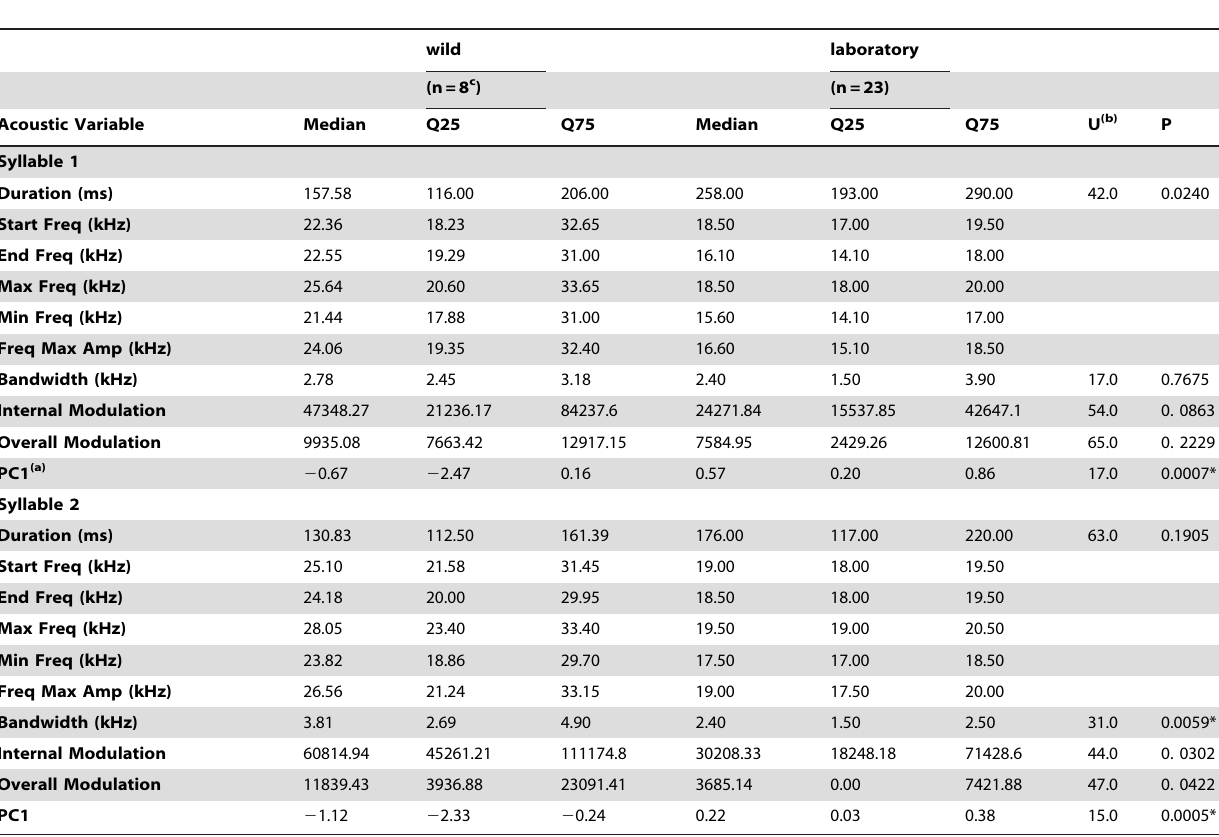
Table 2. Comparison between laboratory- and wild-recorded 2SVs.